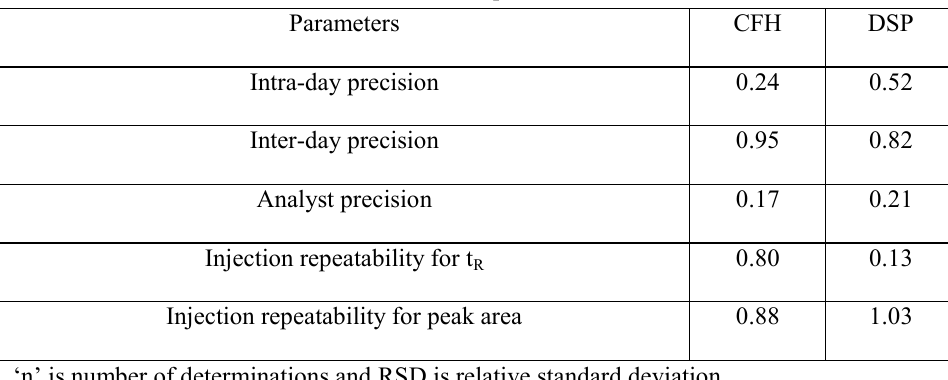
Table 2. Precision expressed as %RSD.